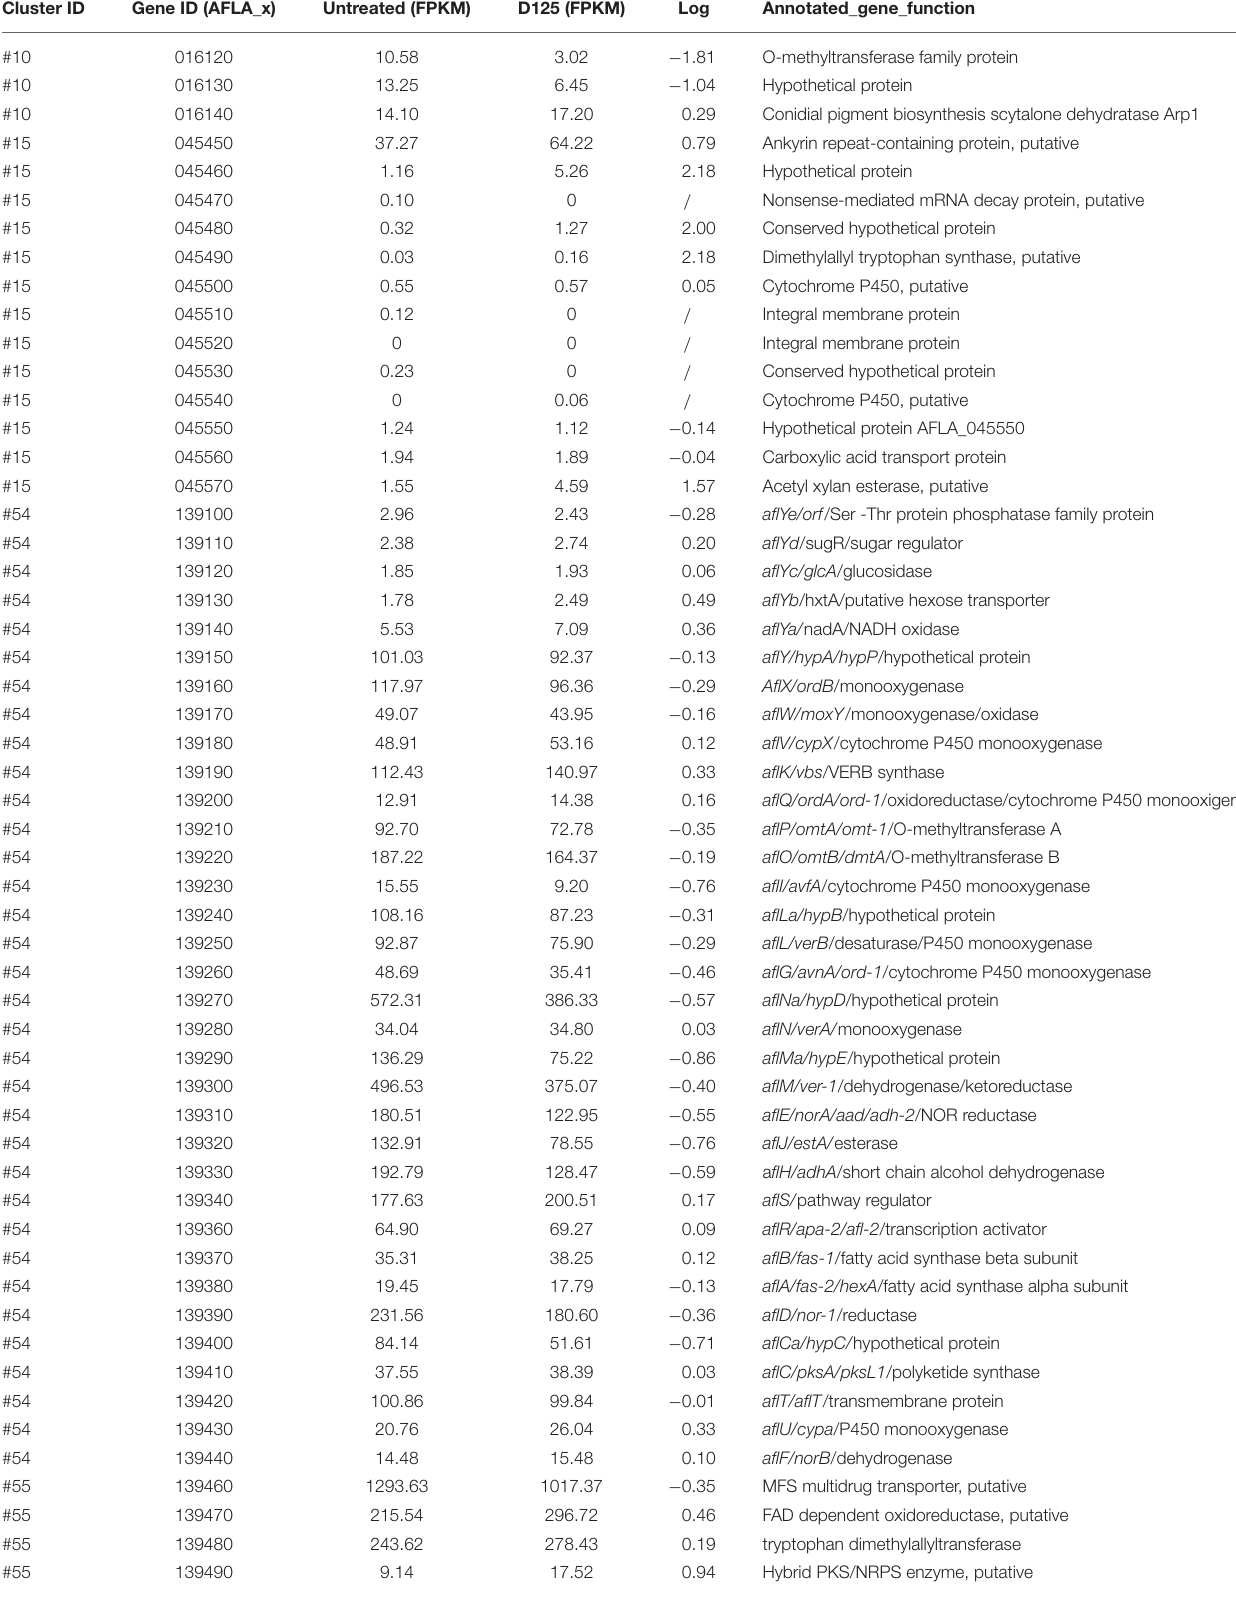
TABLE 3 | Transcriptional activity of genes in the biosynthesis of conidial pigment (#10), aflatrem (#15), aflatoxin (#54), and cyclopiazonic acid (#55). Cluster